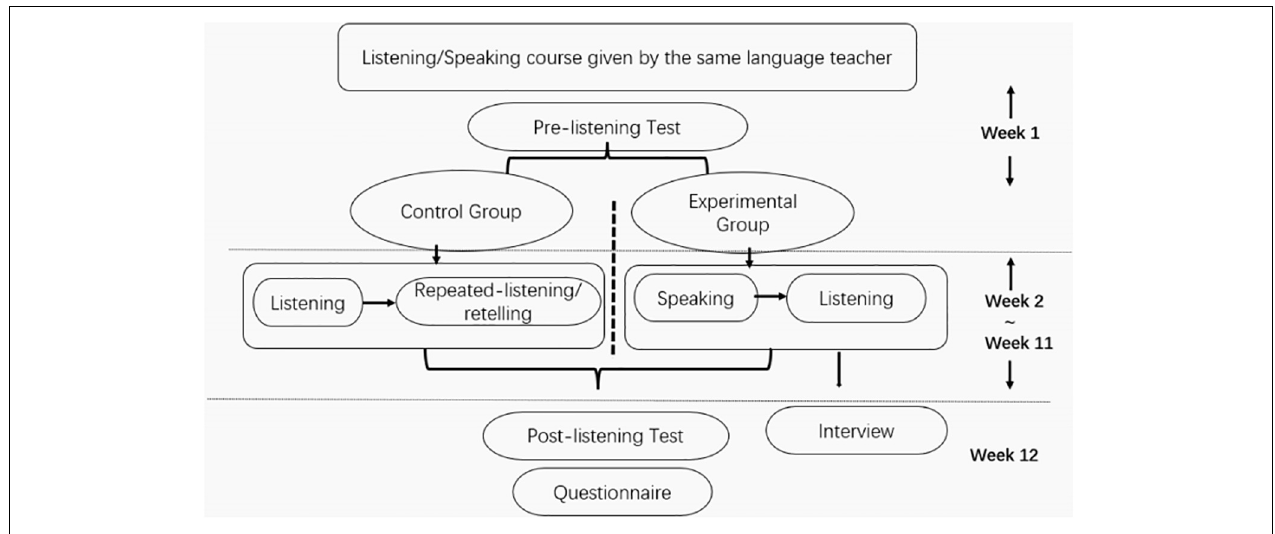
FIGURE 1 | Data collection schedule.